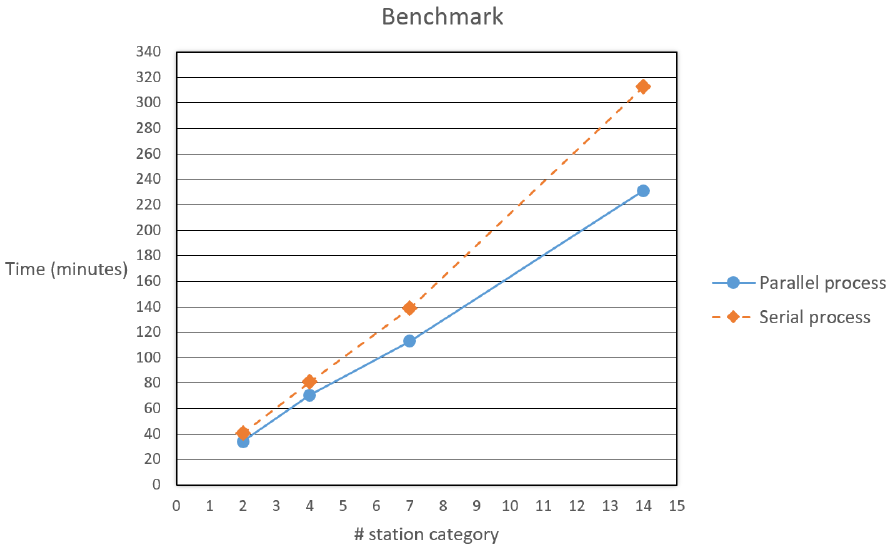
Figure 7. Performance analysis of the serial and parallel versions of the SOS_Insert_Observation.py script.